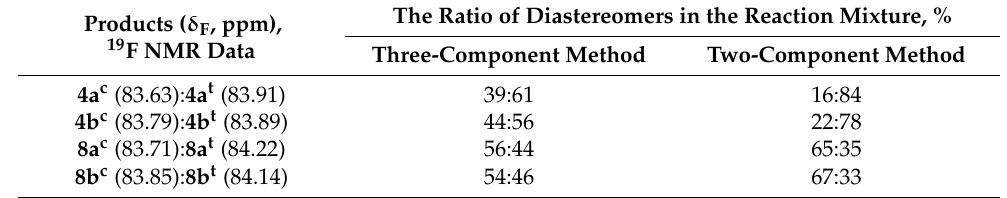
Table 2. The ratio of diastereomeric products 4 and 8 obtained by two- and three-component methods. The Ratio of Diastereomers in the Reaction Mixture, % Products ( δ F , ppm), 19 F NMR Data Three-Component Method Two-Component